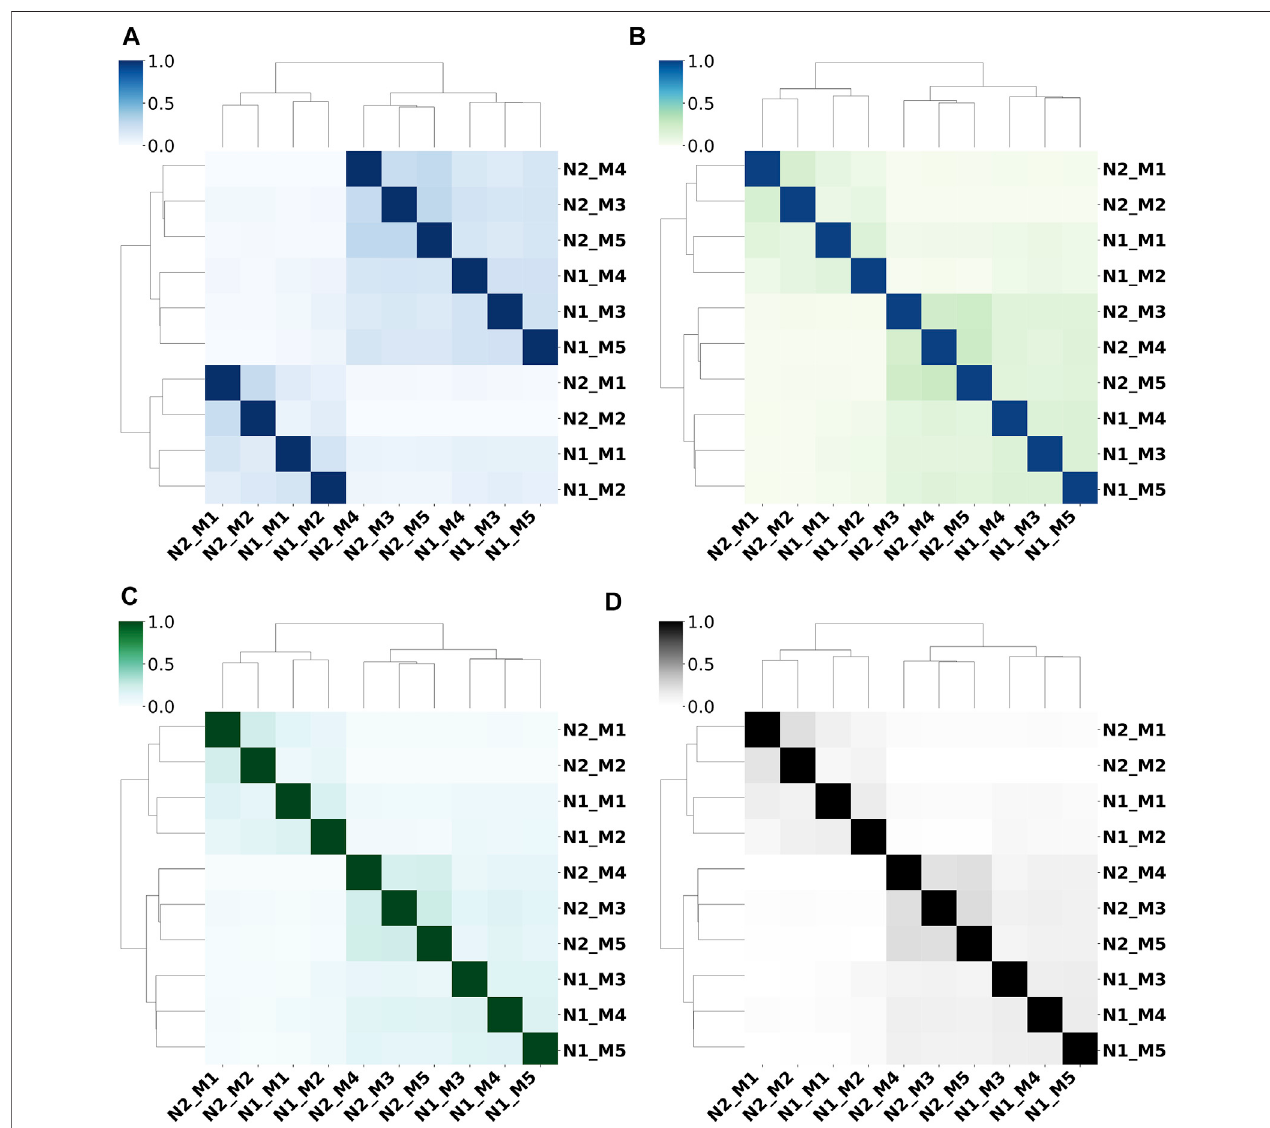
FIGURE 3 | Prediction similarities between different sub-models for (A) all-range, (B) short-range, (C) mid-range, and (D) long-range contacts/distances.